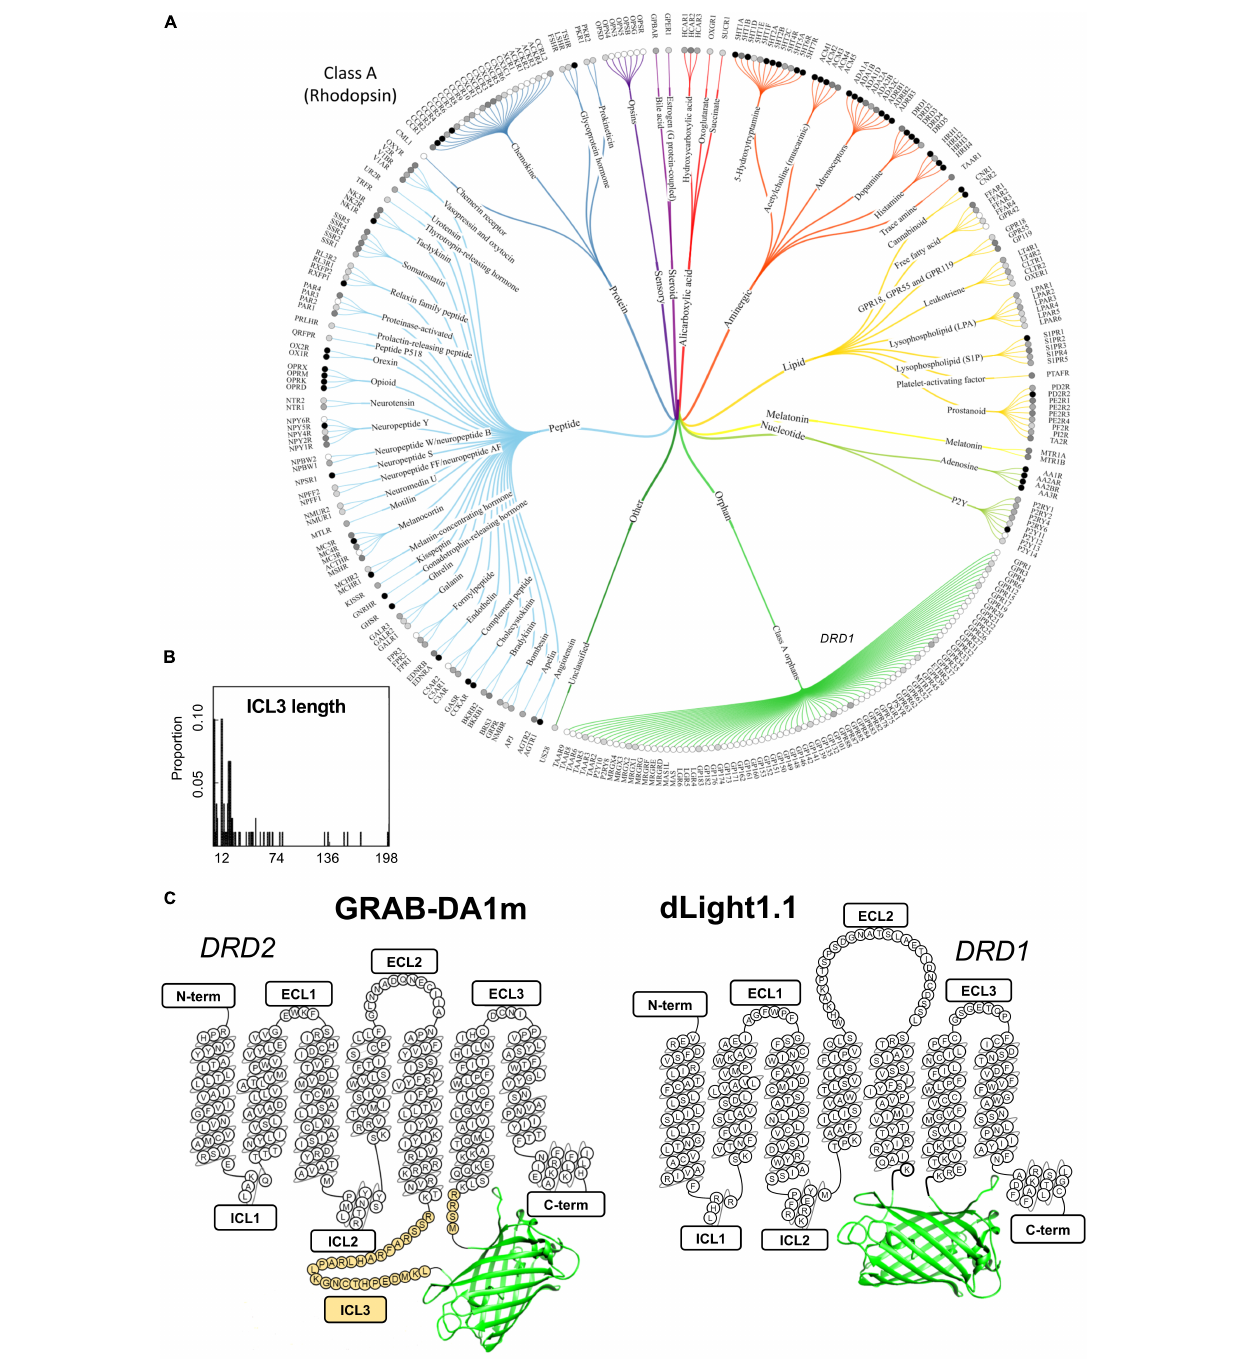
FIGURE 1 | A snapshot of the current GPCR sensor engineering landscape. (A) Class-A GPCR family tree. Receptors are grouped and branches are color-coded based on ligand type. Gray-scale circles in front of the receptor name represent the number of currently available ligands (white: 0, light gray: > 100, gray: > 500 and black: > 1000). Reproduced from Pándy-Szekeres et al. (2018). (B) Length distribution of ICL3 (region where cpGFP is inserted during the sensor engineering process) for several class-A GPCRs highlights the high degree of variability in this region among different receptors. The number of ICL3 aminoacid residues is shown on the x axis, while the relative probability of each length from a total of 89 analyzed GPCRs is shown on the y axis. Reproduced with permission from Otaki and Firestein (2001). (C) Schematic depiction of representative members of the two classes of genetically encoded dopamine sensor classes developed to date: dLight1.1 and GRAB-DA1m. Aminoacid residues of sensor sequence belonging to the original dopamine receptors (DRD1 and DRD2) are shown in the snake-plot. The insertion position of circularly permuted green fluorescent protein (cpGFP) is indicated for both sensor types. N-term, N-terminus; ICL, intracellular loop; ECL, extracellular loop; C-term, C-terminus. Third intracellular loop, ICL3, is highlighted in yellow.